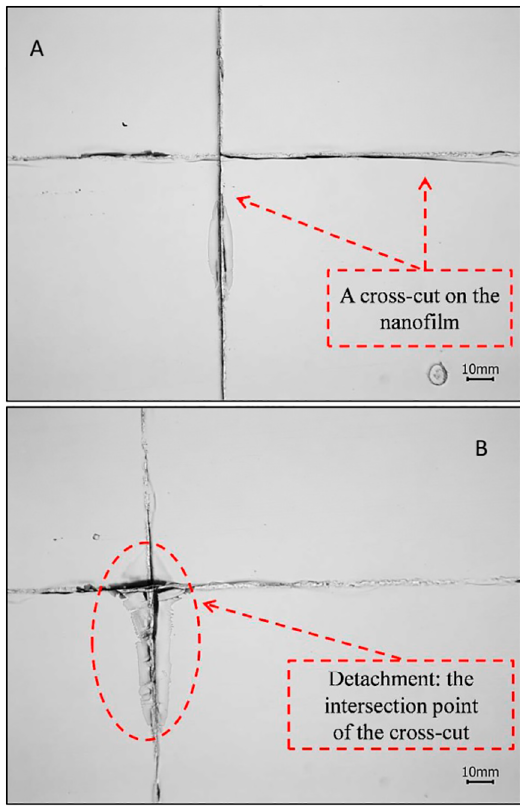
Figure 7. Sample after the adhesion tape test: image (A) the region where there was no detachment of the film; at image (B) the region where there was detachment of the film at the intersection of the cross-cut